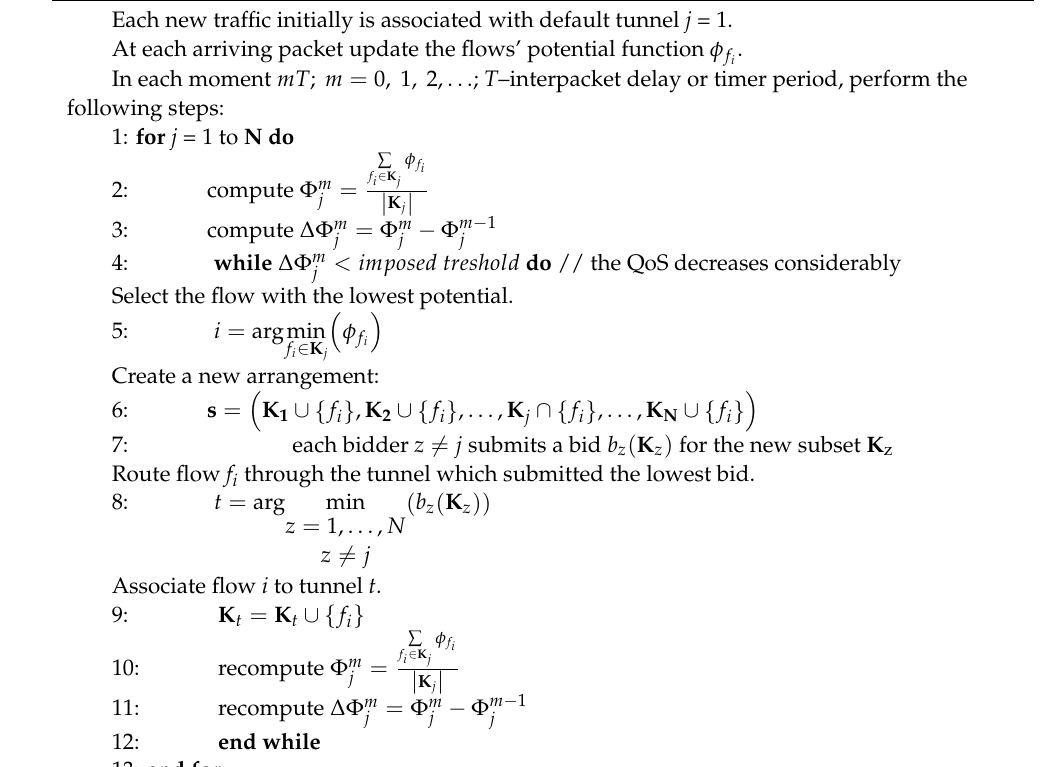
Algorithm 3 Combinatorial Auction-based load-balancing algorithm